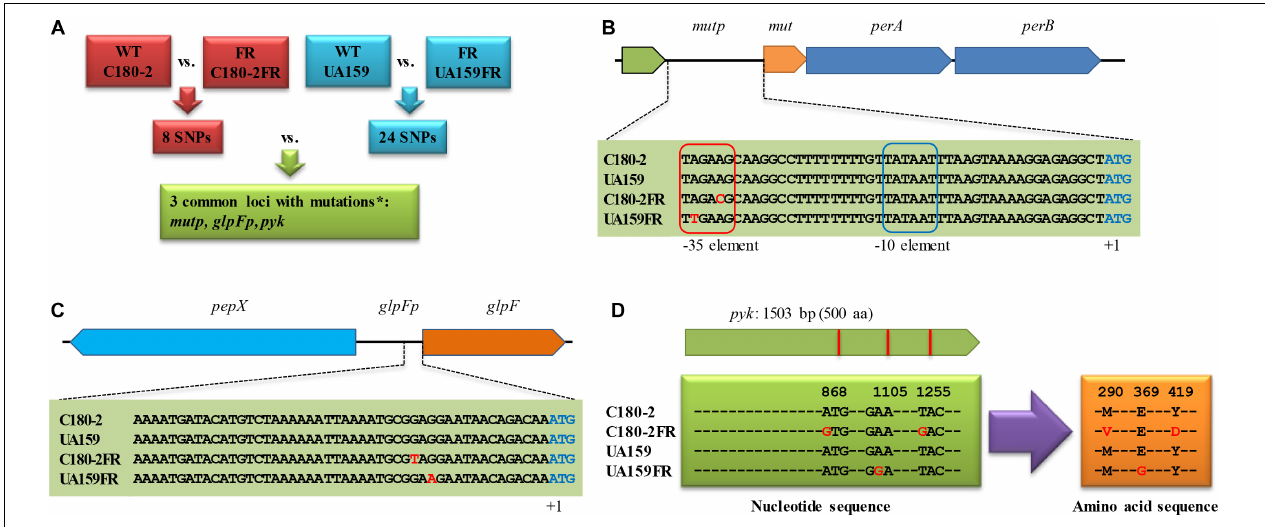
FIGURE 1 | The identification of loci with mutations shared between Streptococcus mutans UA159-FR and C180-2FR. (A) Scheme for the comparison of the SNPs from the two fluoride-resistant S. mutans strains. The nucleotide sequence of loci with mutations shared in both fluoride-resistant S. mutans strains is shown